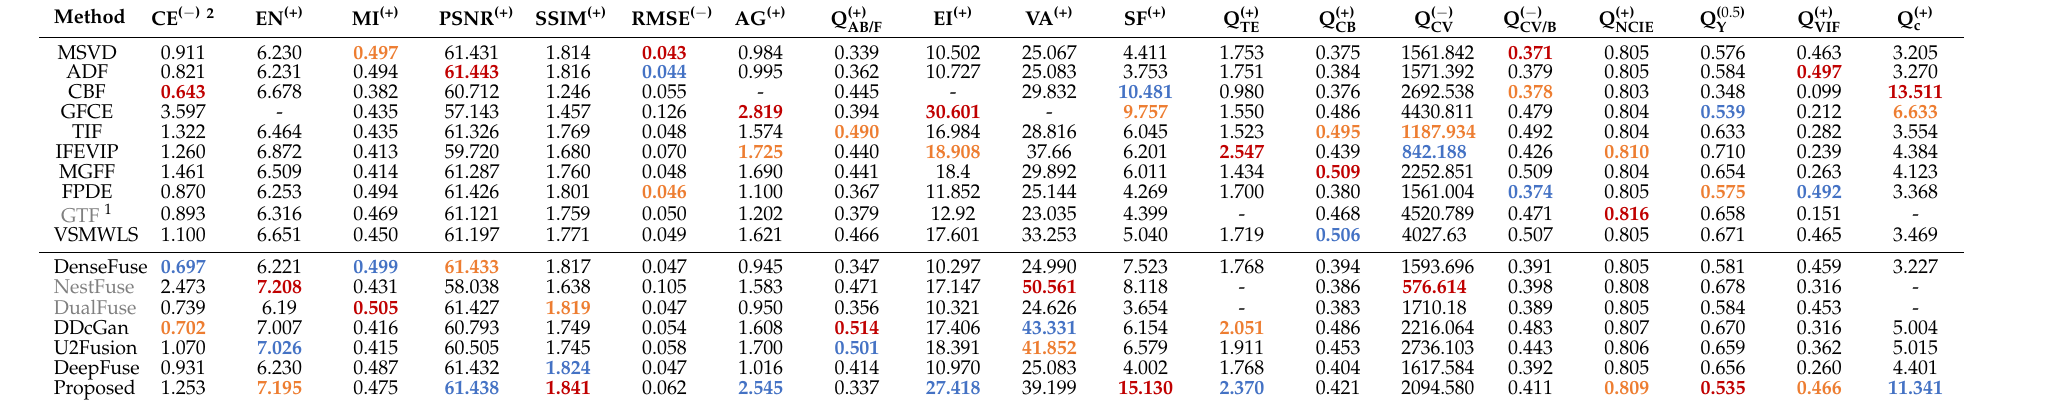
Table 2. Quantitative comparisons of fusion